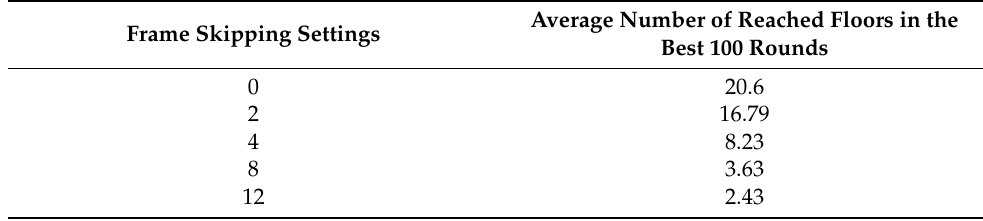
Table 10. Average number of reached floors in the best 100 rounds for different frame skipping settings.